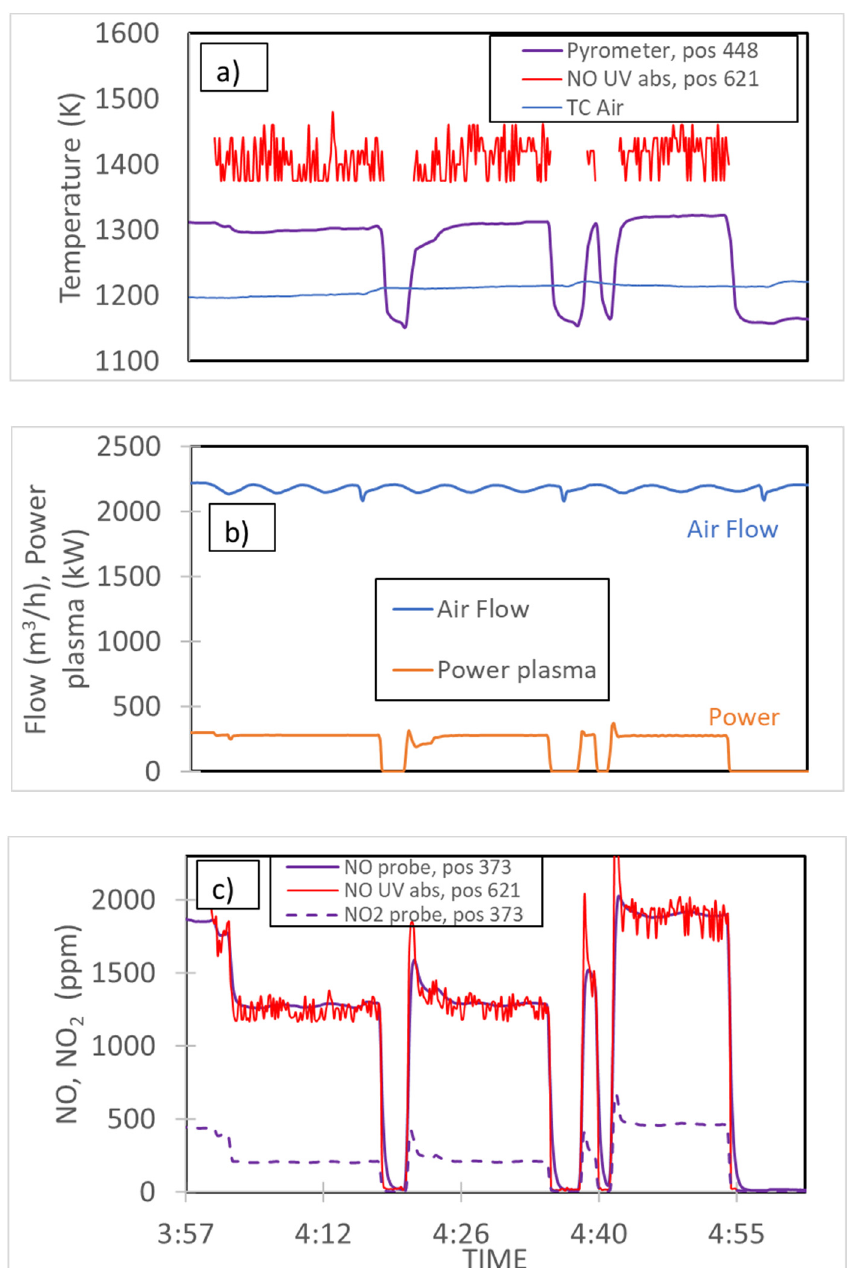
Figure 4. Online measurements of T (UV absorption, Suction pyrometer, TC) ( a ), Plasma power and flow of process air ( b ), NO (UV absorption) and NO and NO 2 (Probe) ( c ) during the N 2 plasma heating. Position number in the legend (pos nnn) shows the distance in cm the beginning of the ECF to the measurement position.